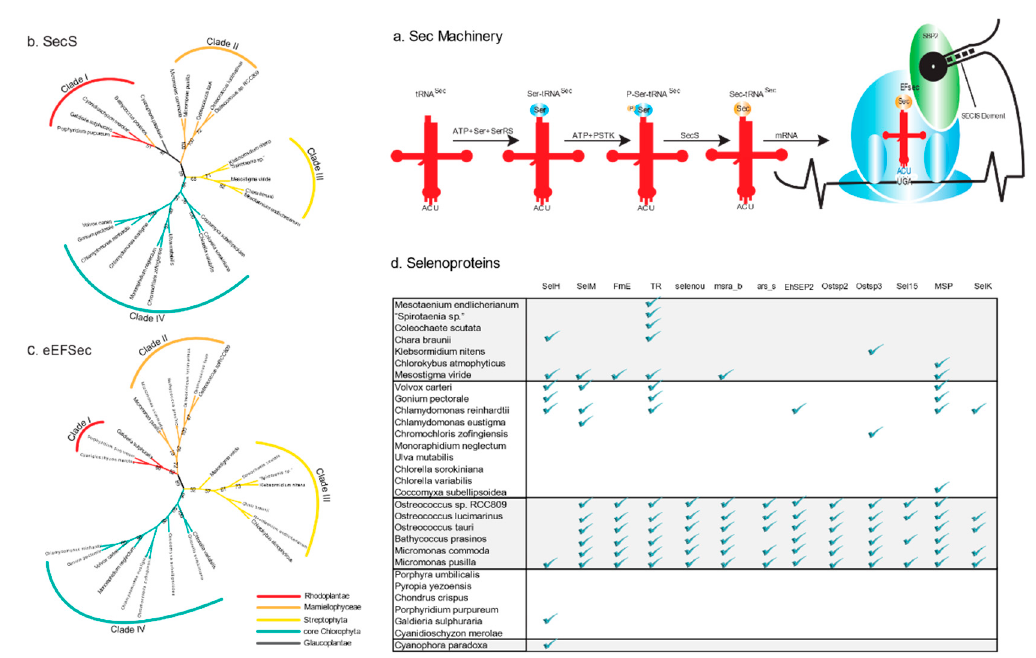
Figure 2. Phylogenetic analysis of enzymes involved in the Sec machinery. ( a ) Schematics of the selenoprotein biosynthesis pathway. ( b , c ) Maximum-likelihood trees of EFsec (Sec-specific elongation factor) and SecS (Sec synthase) respectively. Bootstrap values > 50% are shown. The tree support for internal branches was assessed using 500 bootstrap replicates. ( d ) Distribution of selected selenoproteins across the Archaeplastida. Presence of selenoproteins are shown by green check